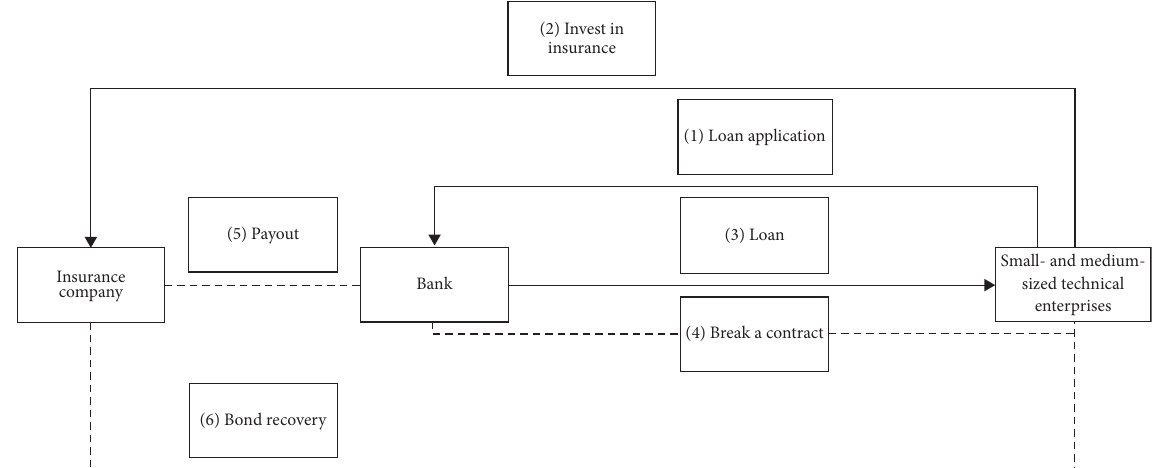
Figure 15: The framework of bank loans and insurance for corporate